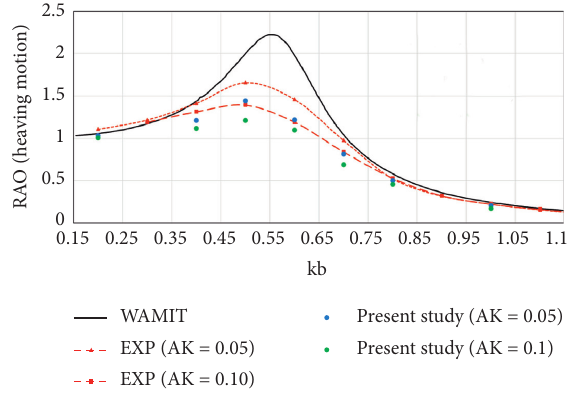
Figure 11: Heave motion RAO of a pontoon.